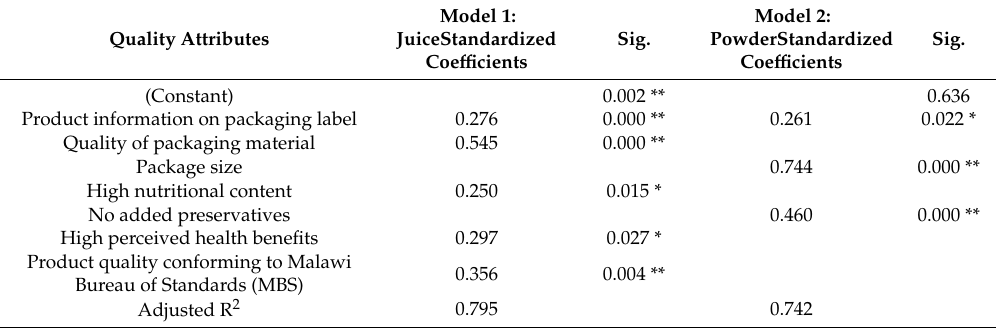
Table 4. Determinants of baobab food product quality attributes on